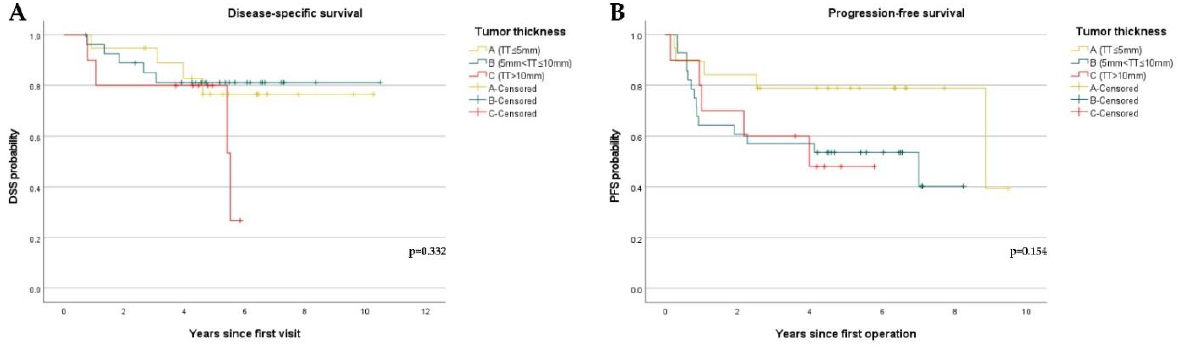
Figure 2. Kaplan – Meier curves showing disease-specific survival (DSS) and progression-free survival (PFS) stratified by depth of invasion (DOI): ( A ) DSS curves stratified by DOI. (A [DOI ≤ 5 mm], n = 30, B [5 mm < DOI ≤ 10 mm], n = 18, C [DOI > 10 mm], n = 9); ( B ) PFS curves stratified by DOI. (A [DOI ≤ 5 mm], n = 30, B [5 mm < DOI ≤ 10 mm], n = 18, C [DOI > 10 mm], n = 9).